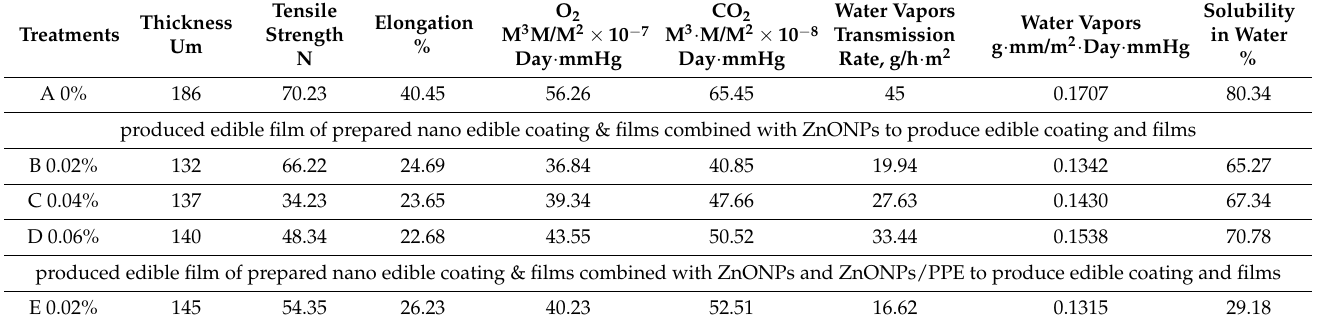
Table 3. Mechanical properties, permeability, and thickness of the prepared nano-edible coating and film solution in combination with ZnONPs and ZnONPs/EPP to produce edible coating and